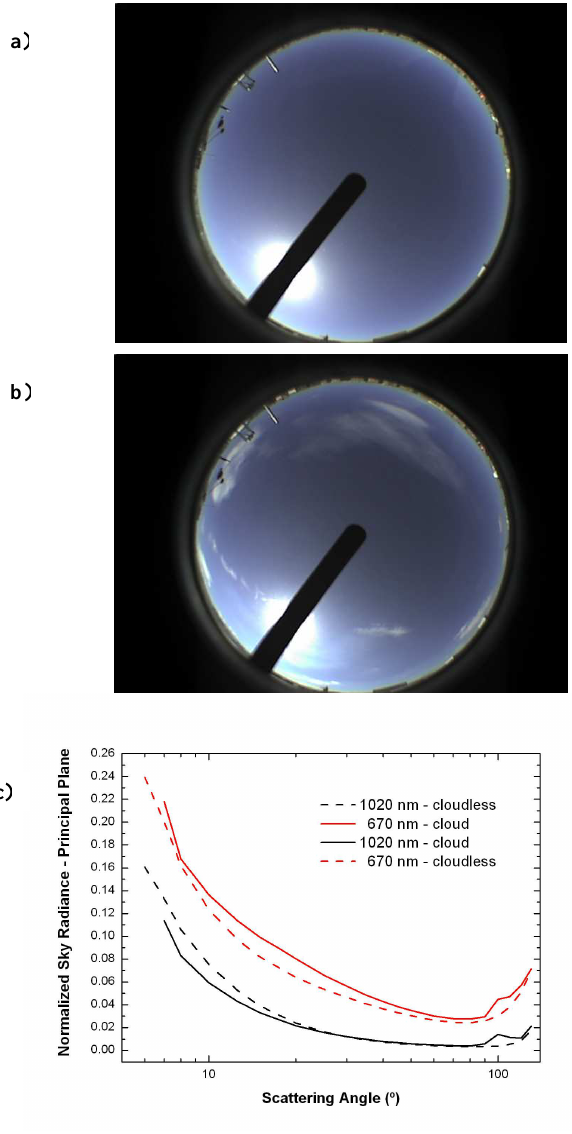
Fig. 1. All-sky image registered on: (a) 6 October 2010 at 10:15h GMT: cloudless; (b) 7 October 2010 at 10:15h GMT: clouds; and (c) normalized principal plane sky radiances at 670 and 1020nm derived for the two